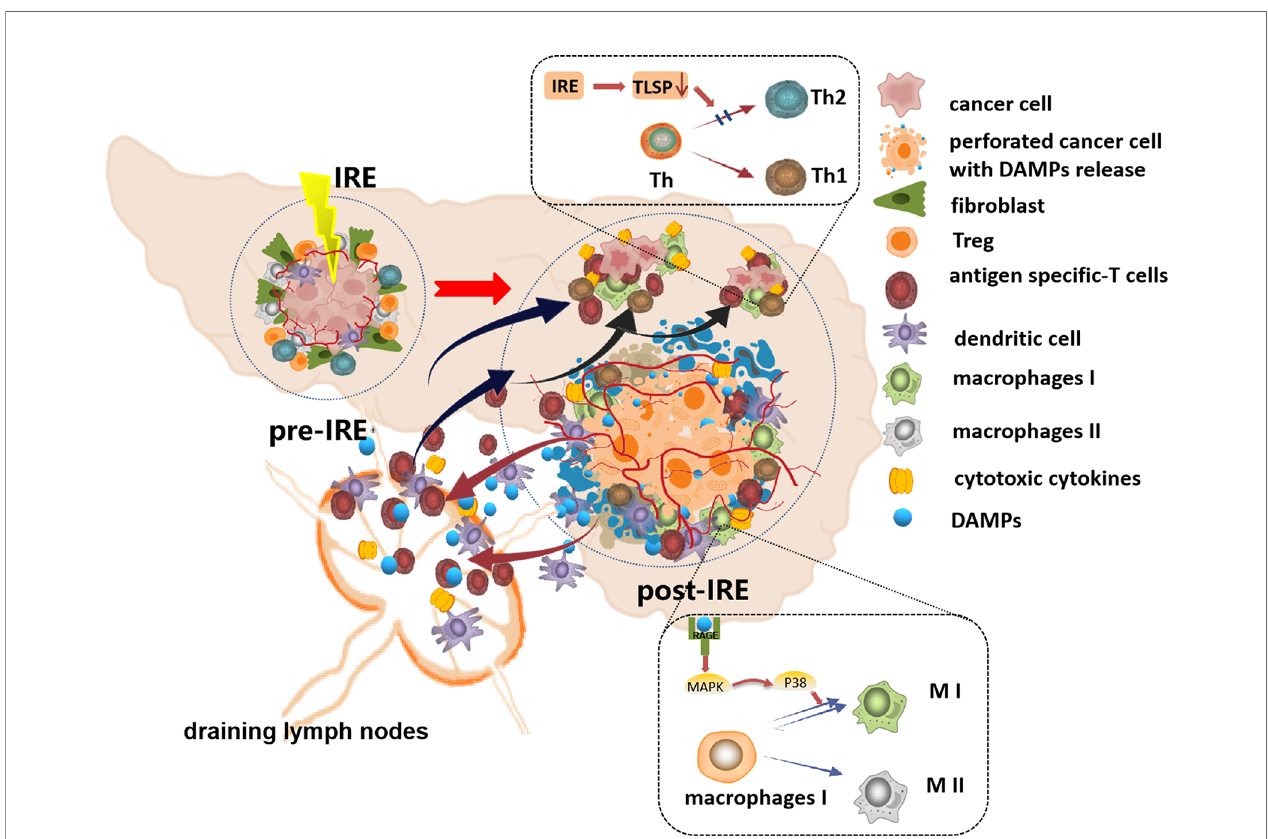
FIGURE 2 | The schematic diagram of the reported mechanisms involved in IRE-induced immune responses. IRE increases the synthesis and secretion of damage- associated molecular patterns (DAMPs), and the DC cells take up these DAMPs, migrate to draining lymph nodes, and then activate tumor antigen-speci fi c T cells, and the activated T cells home to tumor sites to eliminate the residual tumor cells. The DAMPs activated the MAPK – p38 pathway by binding to RAGE, resulting in M1 macrophage polarization. IRE inhibited TSLP in the TME preventing Th2 polarization. Additionally, IRE softens the ECM, increases the density and permeability of tumor vessels, and facilitates the in fi ltration of immune cells into residual tumor